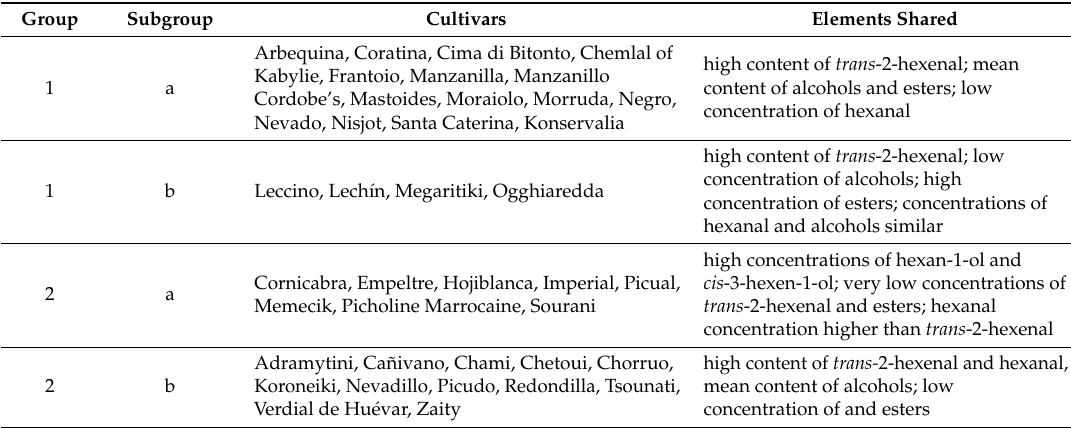
Table 3. Cultivars belonging to the four groups evidenced by HCA, and elements they